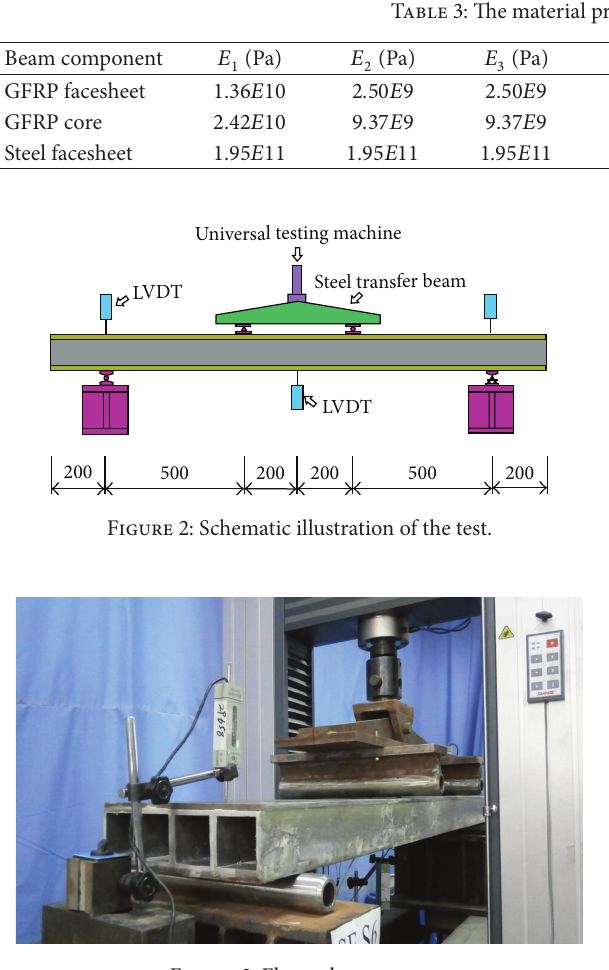
Figure 3: Flexural test